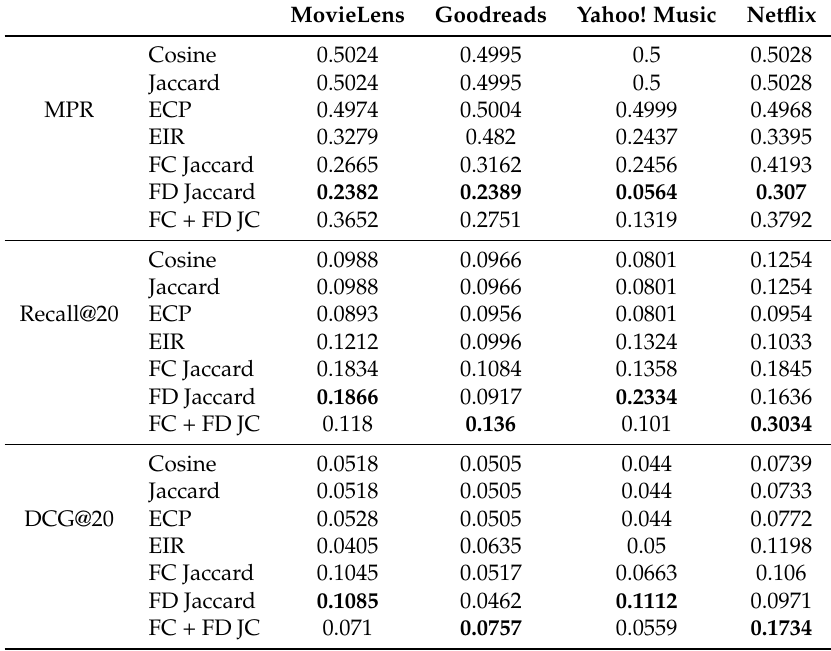
Table 9. Experiments over the first quantile (based on KDE estimations of 25%). Best performing methods are indicated in boldface.